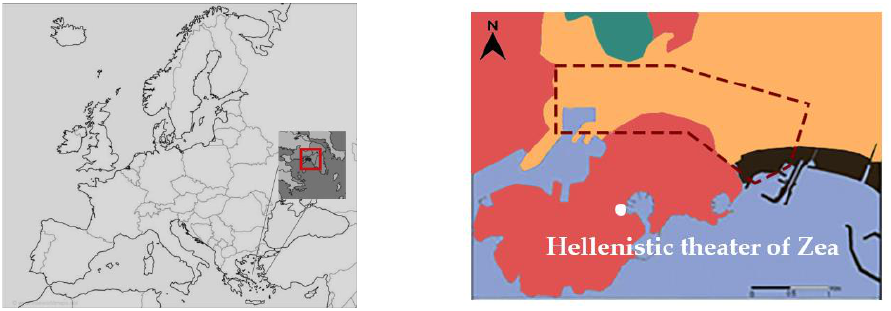
Figure 1. Location and geological map of Piraeus. The red area consists of formations attributed to the Neogene Period (Pliocene and Pleistocene epochs) of the Cenozonic era [41].